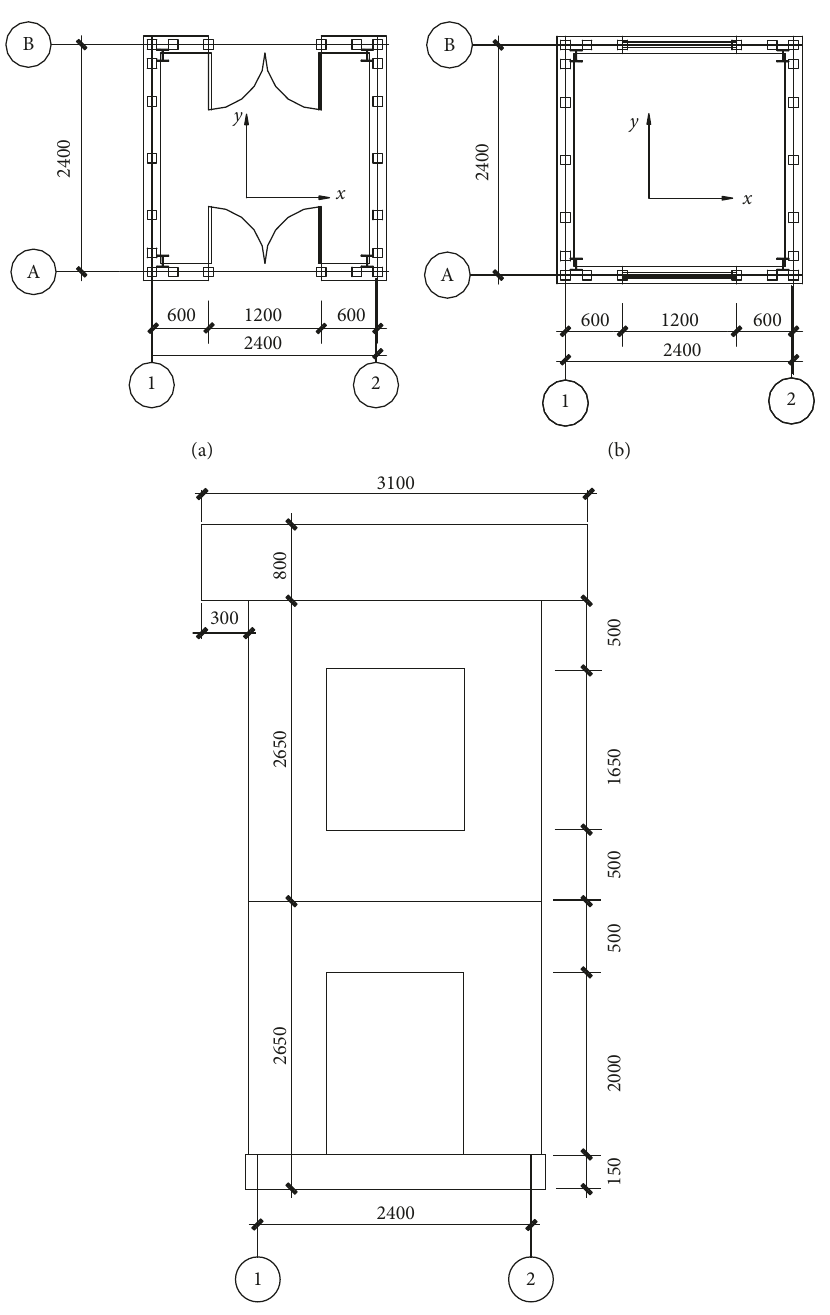
Figure 4: The detailed dimension of experimental model. (a) Plan for first floor. (b) Plan for second floor. (c) Elevation for experimental model. Unit: